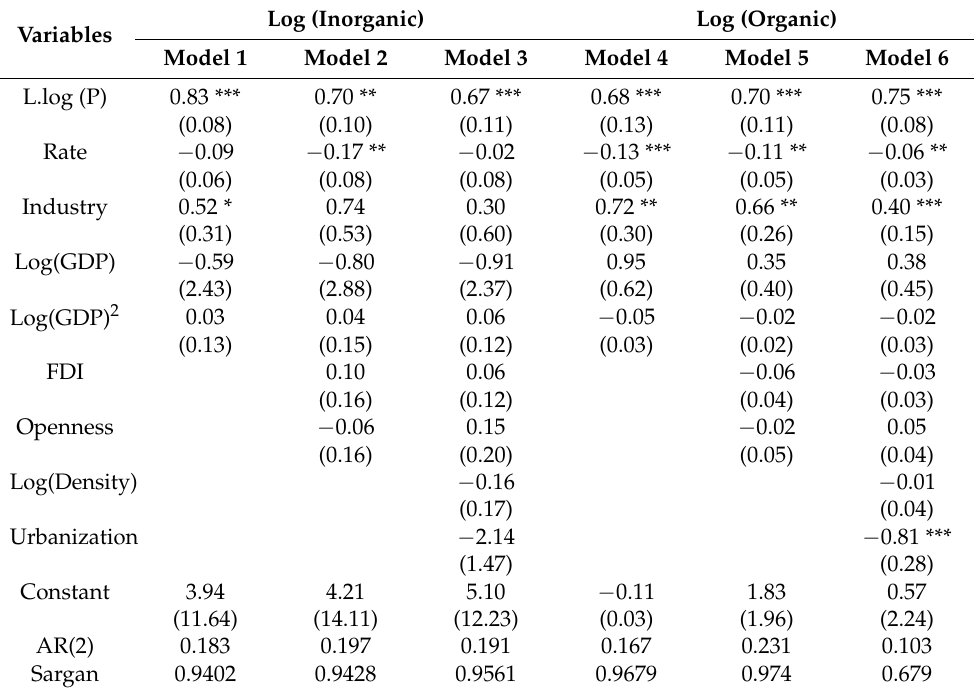
Table 6. The results of SYS-GMM model: Rate as independent variable.